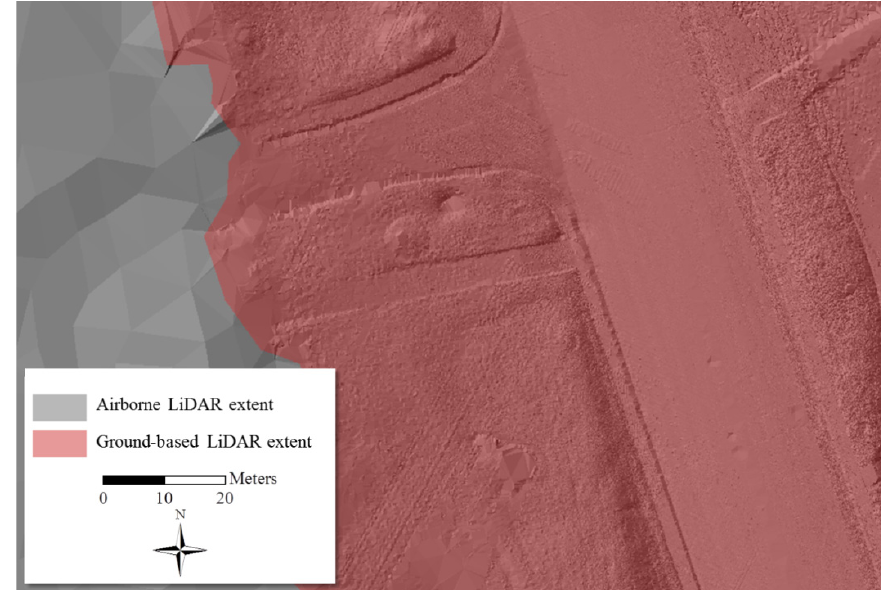
Figure 4. A composite triangulated irregular network (TIN) consisting of the merged bare-earth airborne, mobile, and terrestrial LiDAR data. The location of the ground-based LiDAR data is contained within the red